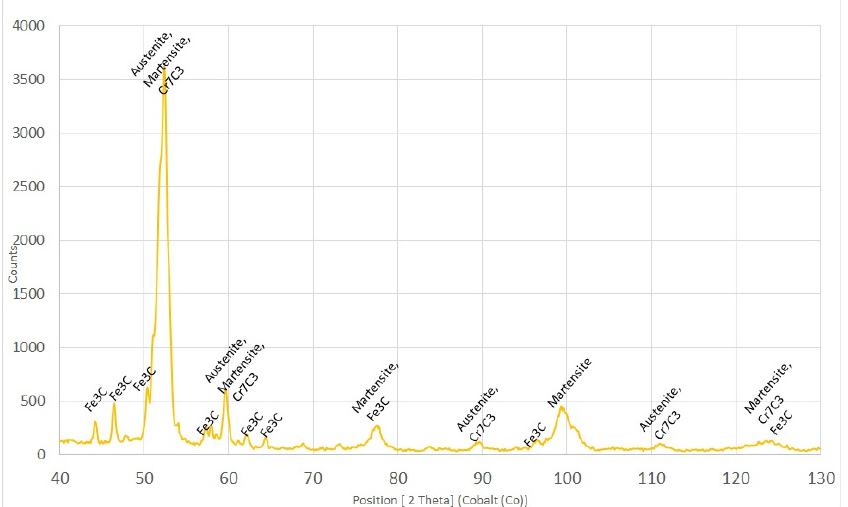
Figure 2. Diffractogram for 17CrNiMo 7-6 steel after low pressure carburizing process with chromium plating.